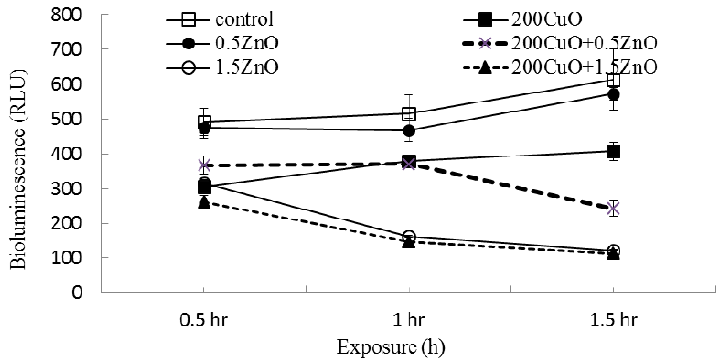
Figure 1. Representative results of bioluminescence activity under three individual NP treatments and two NPs mixtures. “200 CuO + 0.5 ZnO” represents a mixture of 200 mg/L CuO and 0.5 mg/L ZnO.